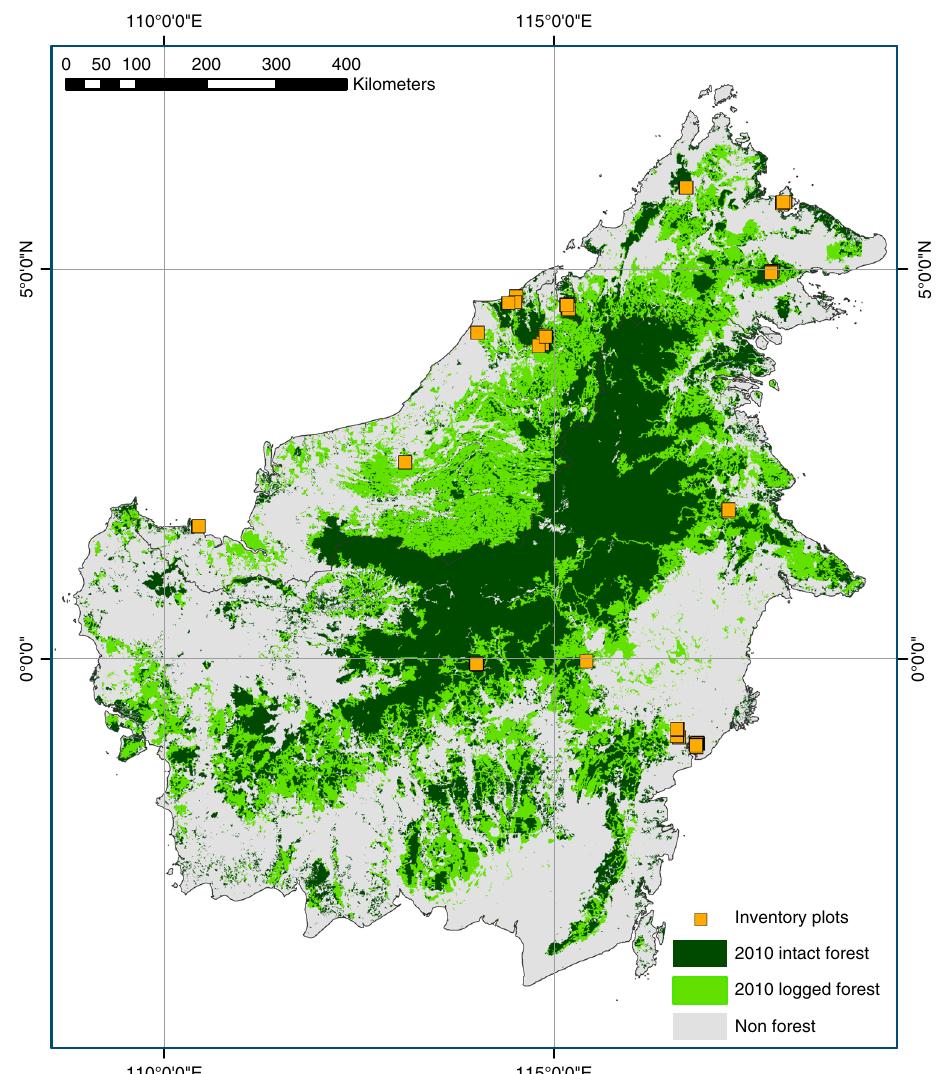
Fig. 1 Locations of 71 long-term forest monitoring plots shown on the 2010 Borneo forest cover map. Intact and logged forest cover are based on Gaveau et al. 2014 59 , accessed at http://www.cgiar-csi.org/portfolio-items/forests-of-borneo. All plots were located in 2010 intact forest areas. Plot symbols overlap, with some obscuring the small forest fragments containing the